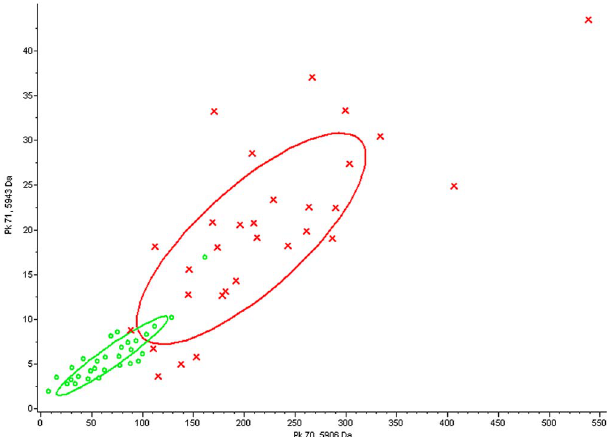
Figure 2. Two-dimensional peak distribution with the peptide mass fi ngerprint from the newly developed advanced schistosomiasis (NDAS) and control groups. The red cross indicates healthy controls and the green circle indicates newly developed advanced schistoso- miasis (NDAS)